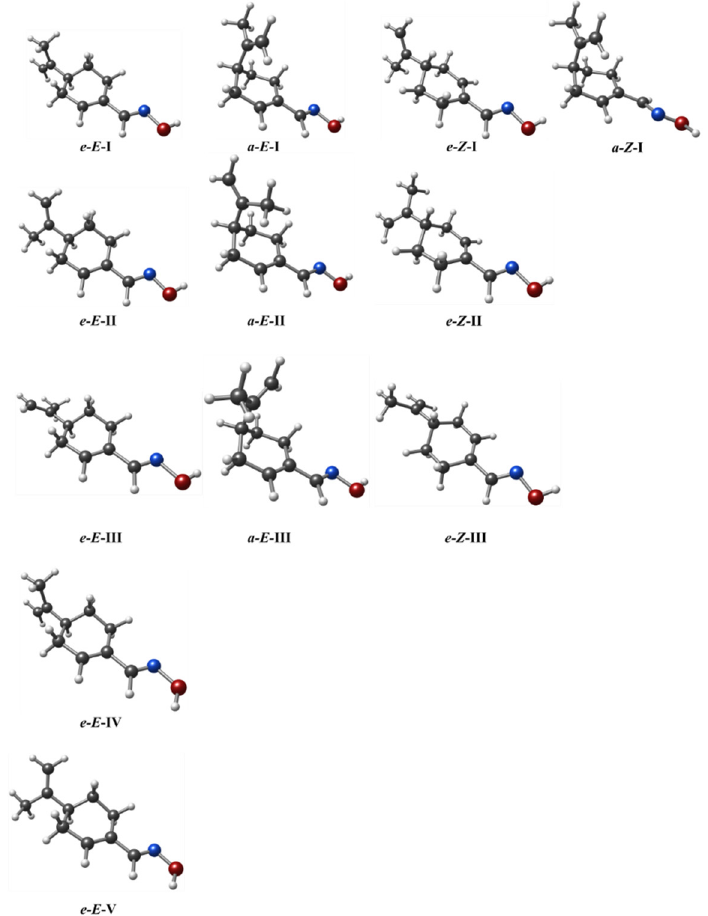
Figure 1. The predicted lowest-energy conformers of perillartine below 2000 cm − 1 relative to the global minimum computed at the B3LYP-GD3BJ/6-311++G(d,p) level of theory. Table 1. Theoretical spectroscopic parameters for low-energy conformers of perillartine computed at the B3LYP-GD3BJ/6-311++G(d,p) level of theory. Parameters e - E -I e - E -II a - E -I e - E -III a - E -II a - E -III e - Z -I e - Z -II a - Z -I e - Z -III e - Z -IV e - Z -V A 1